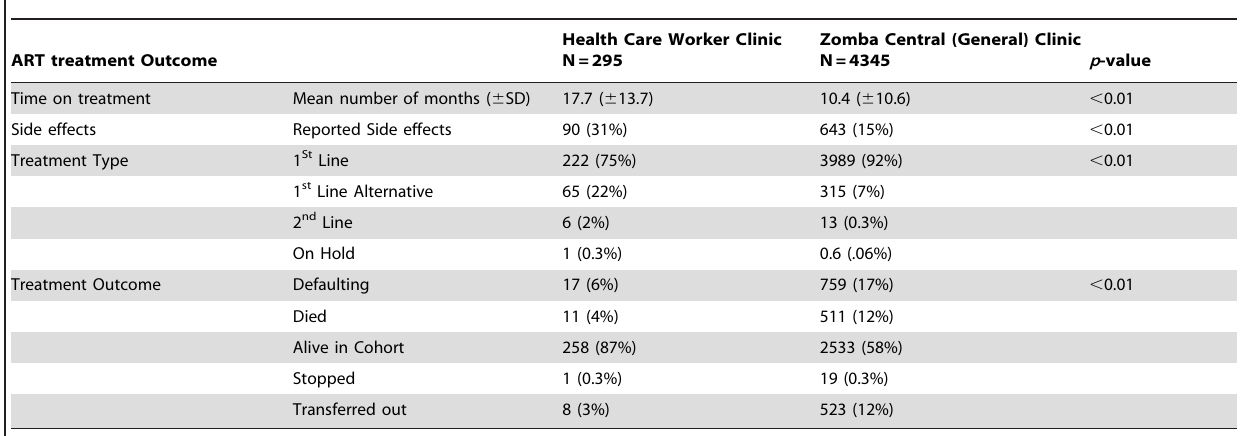
Table 2. Treatment outcomes in patients followed at HCW clinic vs. general clinic at time of study.